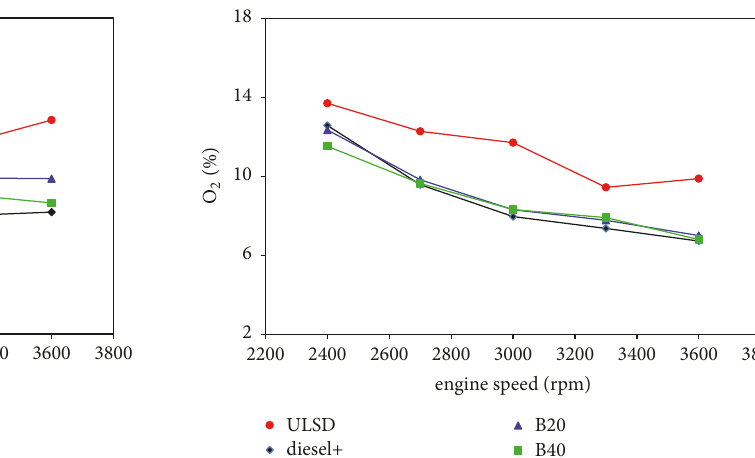
Figure 7: HC emission variation with engine speed at 80% load.